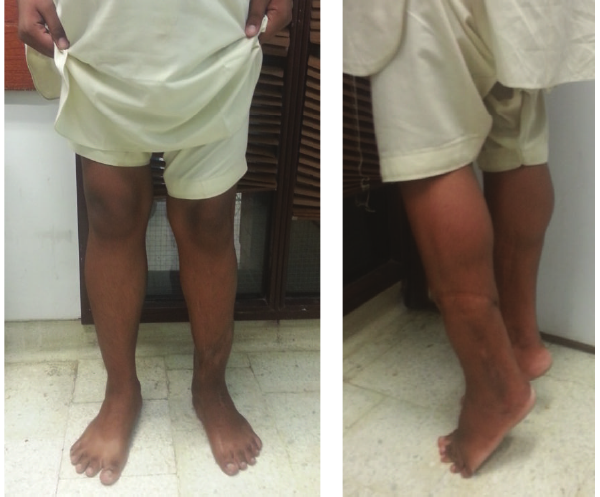
Figure 4: 12-year